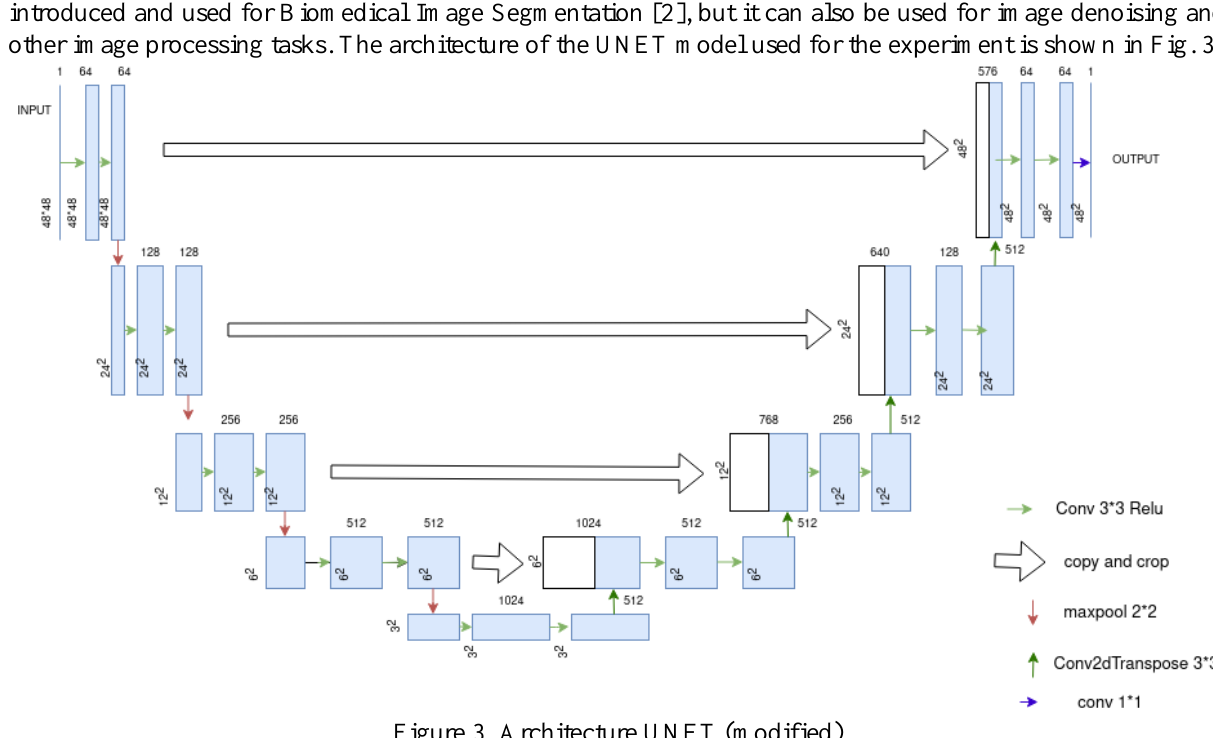
Figure 3. Architecture UNET